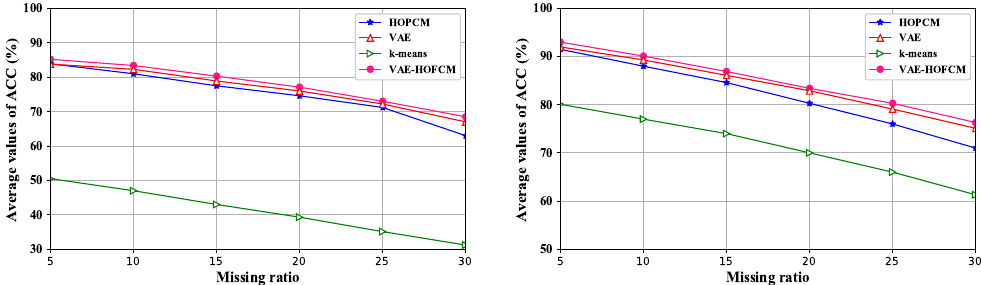
Figure 6. Clustering accuracy of ACC.